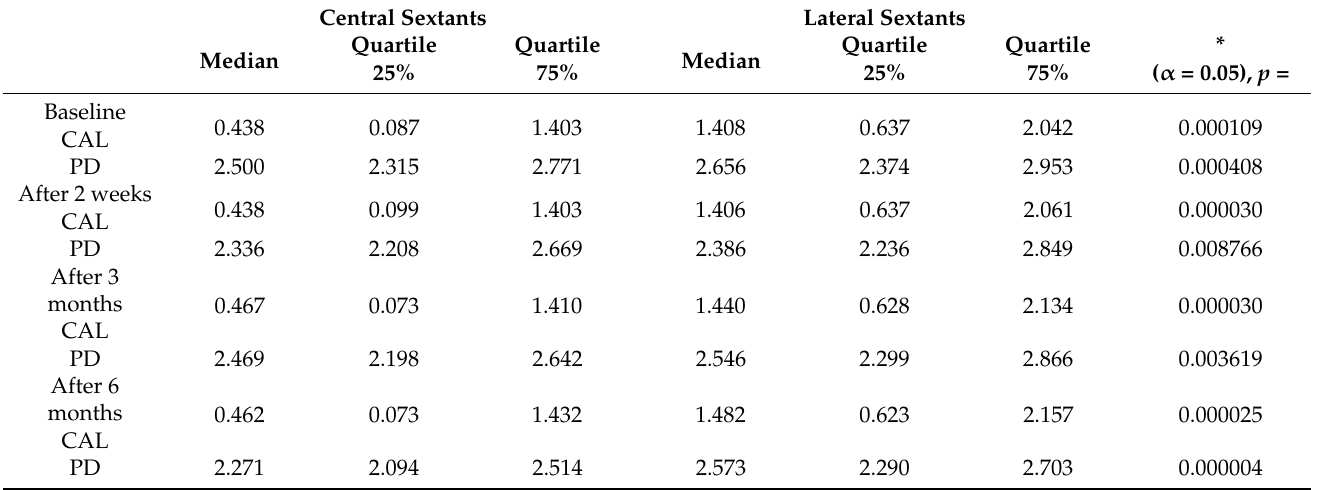
Table 2. Comparison of clinical indicators between central and lateral sextants in group I (PERIO–